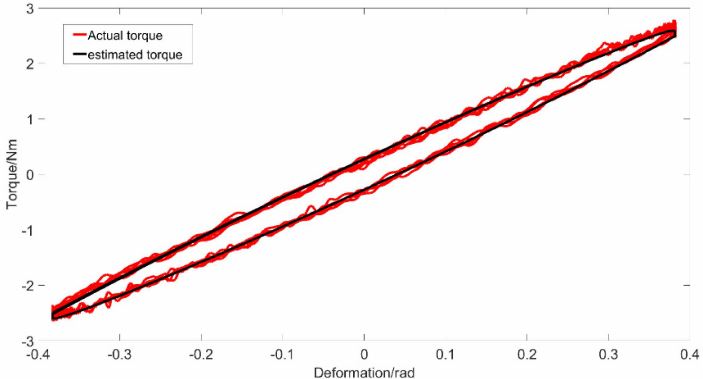
Figure 10. Rubber element torque deformation variable fitting curve. The estimated torque is in good agreement with the actual torque, which can accurately reflect the hysteresis characteristics of the rubber element.